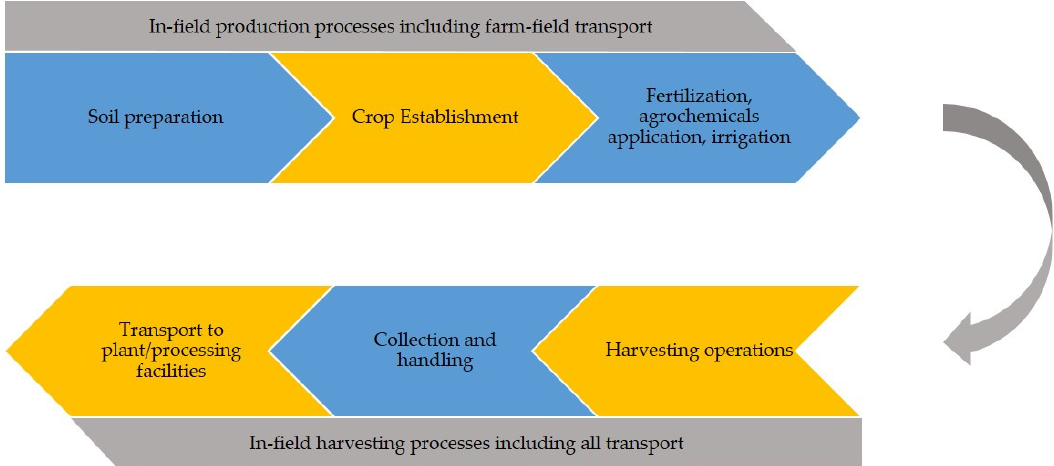
Figure 2. Processes included in this review’s boundary.